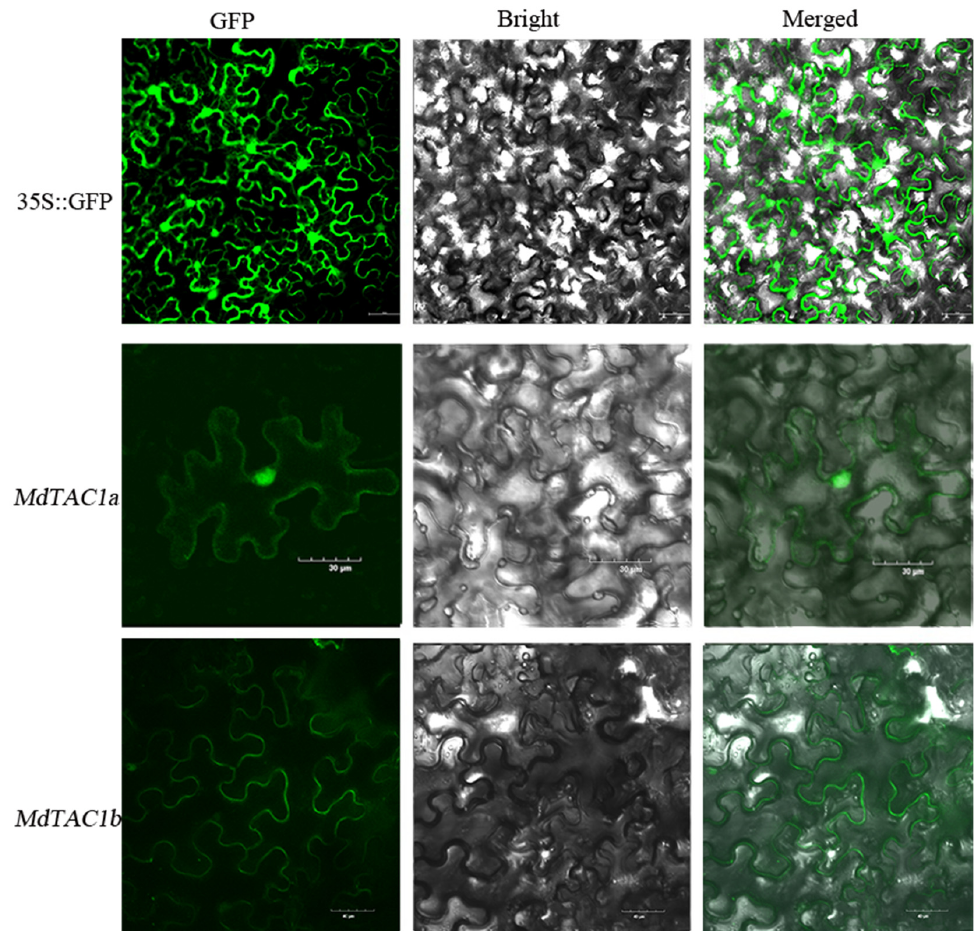
Figure 1. Subcellular localization of MdTAC1a and MdTAC1b in tobacco leaves. 35S::GFP represented the pCambia1300 with GFP vector and the pCambia1300 empty vector was detected in the nucleus and membrane. MdTAC1a was detected on the nucleus and membrane, and MdTAC1b was detected on the membrane.